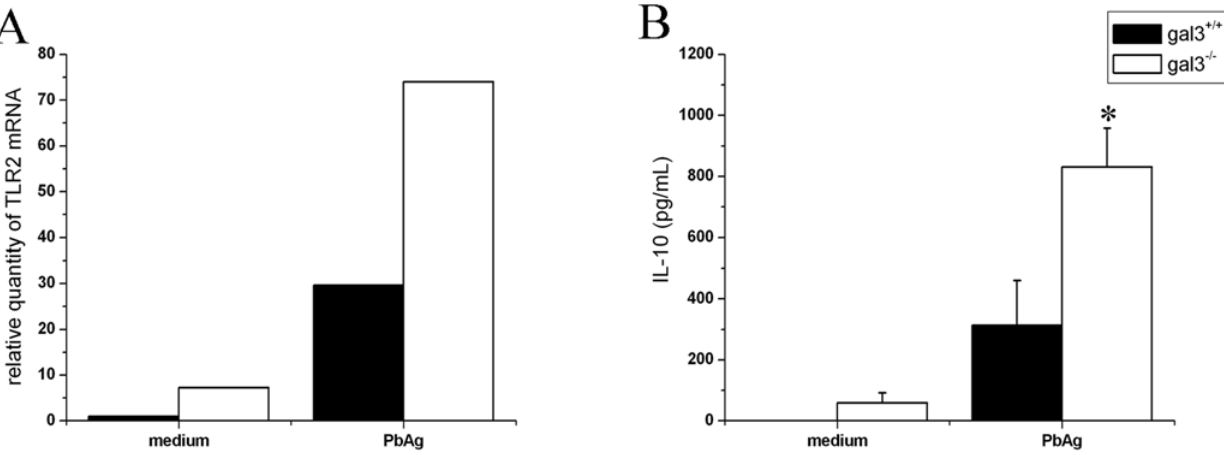
Figure 7. P.brasiliensis antigens induce higher TLR2 transcript levels in gal3 2 / 2 thioglycollate-elicited macrophages. (A) Real Time quantitative RT PCR for TLR2 using mRNA from unstimulated or PbAg (20 m g/mL)-treated macrophages, 4 hours after stimulation. cDNA contents were normalized on the basis of predetermined levels of b -actin. TLR2 transcript level was higher in PbAg-stimulated gal3 2 / 2 macrophages (open bars) compared with gal3 + / + macrophages (black bars). (B) Thioglycollate-elicited macrophages from gal3 + / + (black bars) and gal3 2 / 2 (open bars) mice were incubated with the indicated stimuli for 48 hours; IL-10 was quantified in the cell supernatants by ELISA. Results represent the mean 6 SD obtained from duplicate wells. Results are representative of two independent experiments that provide similar results. * P , 0.05, compared with infected gal3 + / +